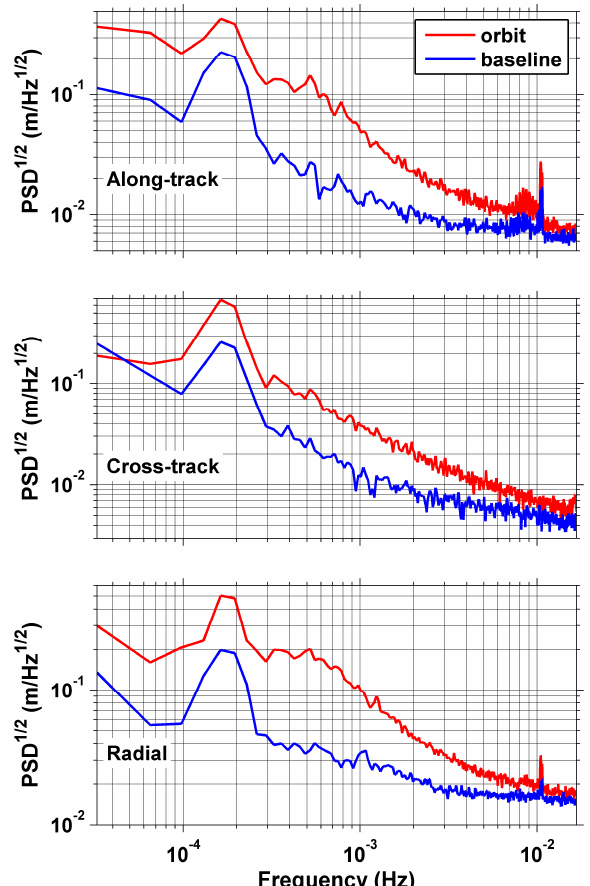
Figure 1. PSD 1 / 2 s estimated from postfit residuals of kinematic orbits of GRACE A and kinematic baselines between GRACE A and B.